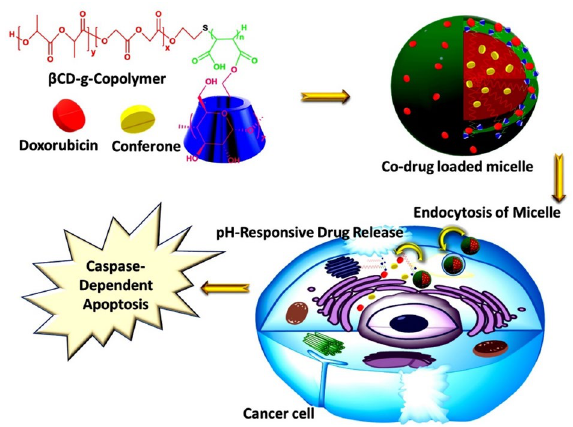
Figure 1. The graphical schematic of the general